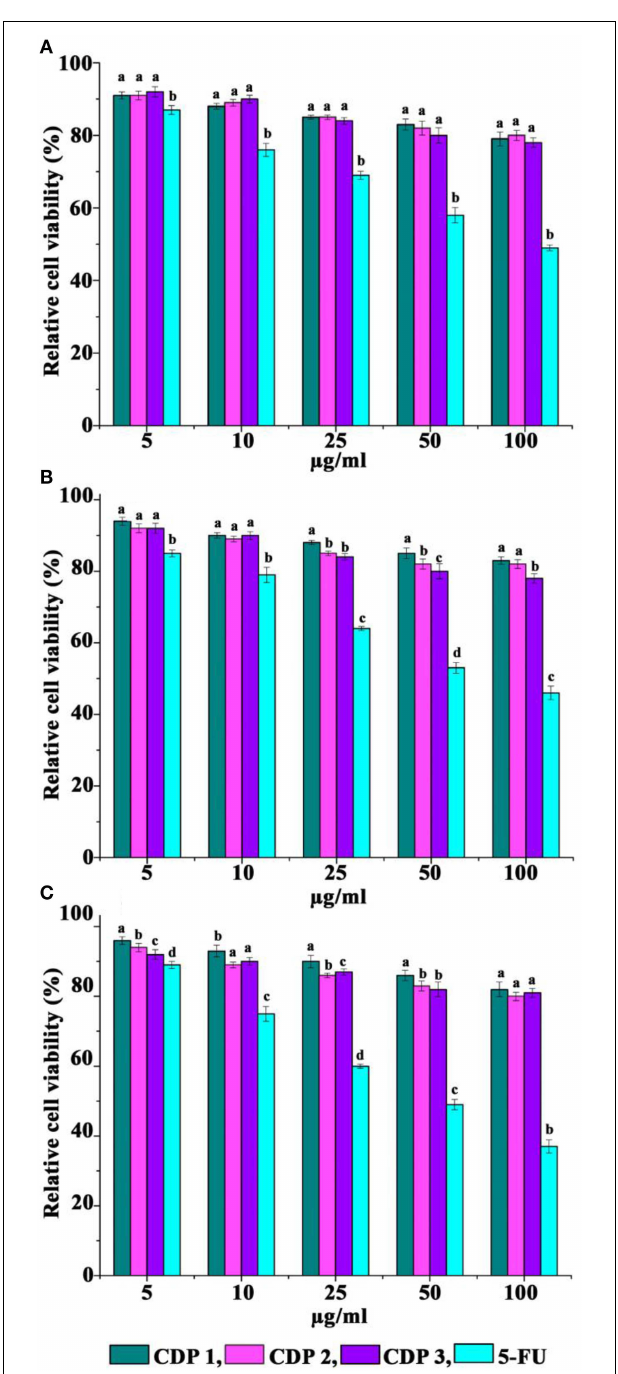
FIGURE 7 | Cytotoxicity of cyclic dipeptides against normal cell lines. (A) FS normal fibroblast, (B) VERO, and (C) L231 normal lung epithelial. Error bars indicate the standard deviations of three measurements. Different letters in the superscript were significantly different according to Duncan’s multiple range test ( p <